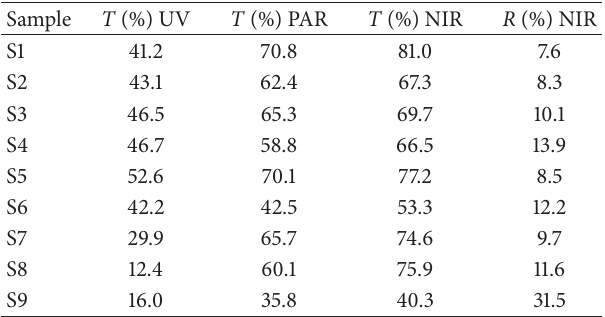
Figure 6: Spectral transmittance of (a) control and blend samples withNIR-reflectivepigmentsand(b)controlwithNIRreflectiveand other UV additives. Table 7: Average values in percentage for transmittance and reflectance in UV, PAR, and NIR regions for control and various blend